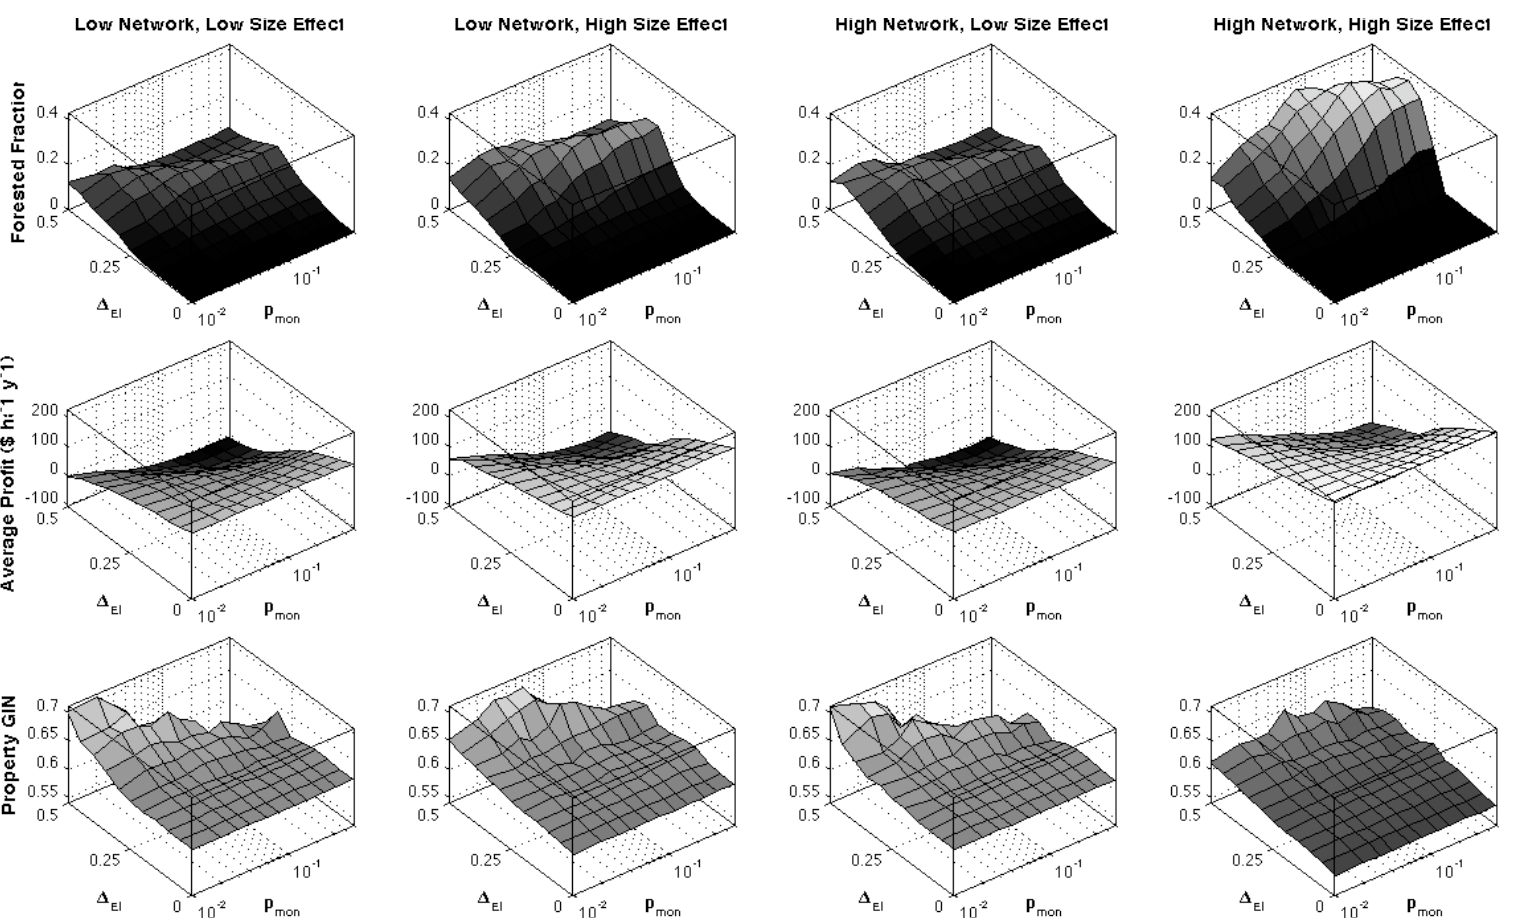
Figure A5.4: Response surfaces for Policy Scenario 3 – Sensitivity to change in expected income Δ EI and in monitoring probability p mon , non­ tiered environmental licensing. Surfaces in row 1 show average forested fraction across the landscape; row 2 shows average profit per hectare of property per year; row 3 shows the level of land aggregation measured by the property GINI coefficient. Each column represents a different scenario of rancher